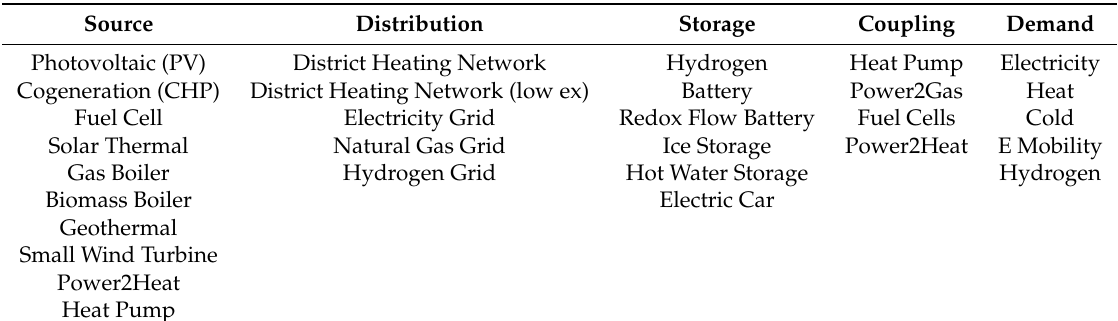
Table 2. Matrix of all conceivable energy technologies for a distributed energy supply system clustered by their intended purpose. This matrix is the result of a joint brainstorming of the partners involved in the ENaQ project. In addition, further technologies would be conceivable, but these were not considered due to their market maturity or other general